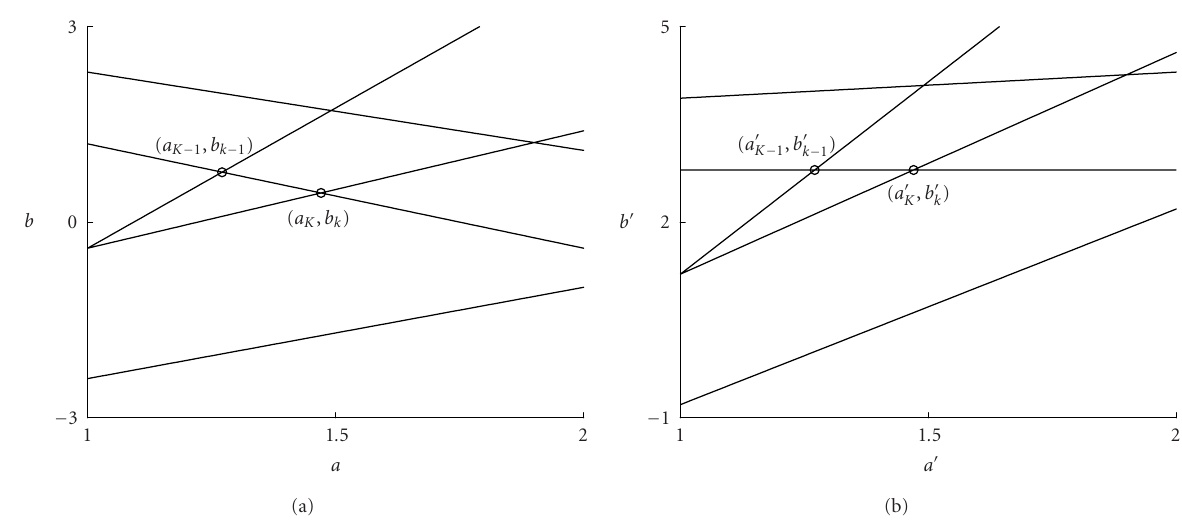
, b (cid:4) k − ); ( a (cid:4) k , b (cid:4) k ) 1 1